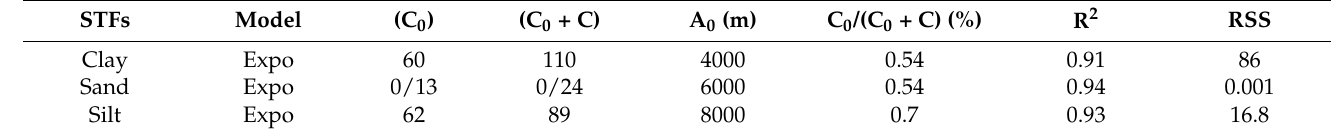
Table 4. The best-fitted semi-variogram results on sand silt and clay soil particles.